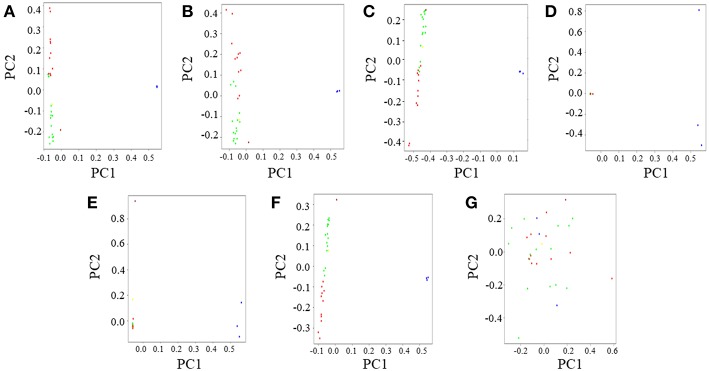
Principal Component Analysis (PCA) of gorilla genomes. PCA plots showing genetic differentiation among query gorilla genomes. The data subsets were generated using top 1,531 most informative SNPs detected through various AIMs determining approaches. (A) PCA of the CSS (354,080 SNPs); Here, the X-axis (PC1) explained 45% variance while the Y-axis (PC2) explained 23% variance of the data. (B) PCA of Infocalc-1,531; In this case, the X-axis (PC1) explained 45% variance while the Y-axis (PC2) explained only 21% variance of the data. (C) PCA of Admixture-1,531; In this case, the X-axis (PC1) explained 68% variance while the Y-axis (PC2) explained 22% variance of the data. (D) PCA of SmartPCA-1,531; Here, the X-axis (PC1) explained 88% variance while the Y-axis (PC2) explained only 6% variance of the data. (E) PCA of FST-1,531; In this case, the X-axis (PC1) explained 85% variance while the Y-axis (PC2) explained only 5% variance of the data. (F) PCA of Consensus-1,531; In this case, the X-axis (PC1) explained 82% variance while the Y-axis (PC2) explained 10% variance of the data. (G) PCA of Random-1,531; Here, the X-axis (PC1) explained 28% variance while the Y-axis (PC2) explained 24% variance of the data. Notable populations are marked with circles such that the blue circles represent eastern lowland gorillas; brown represents the cross river gorilla; and green, red and yellow represents western lowland gorillas of Cameroonian, Congolese and Equatorial Guinean ancestry, respectively. In all cases, PCA was performed in PLINK v1.9 and the top four principal components (PCs) were extracted. Top two PCs (PC1 and PC2), explaining the highest variance of the data were plotted in R v3.2.3.